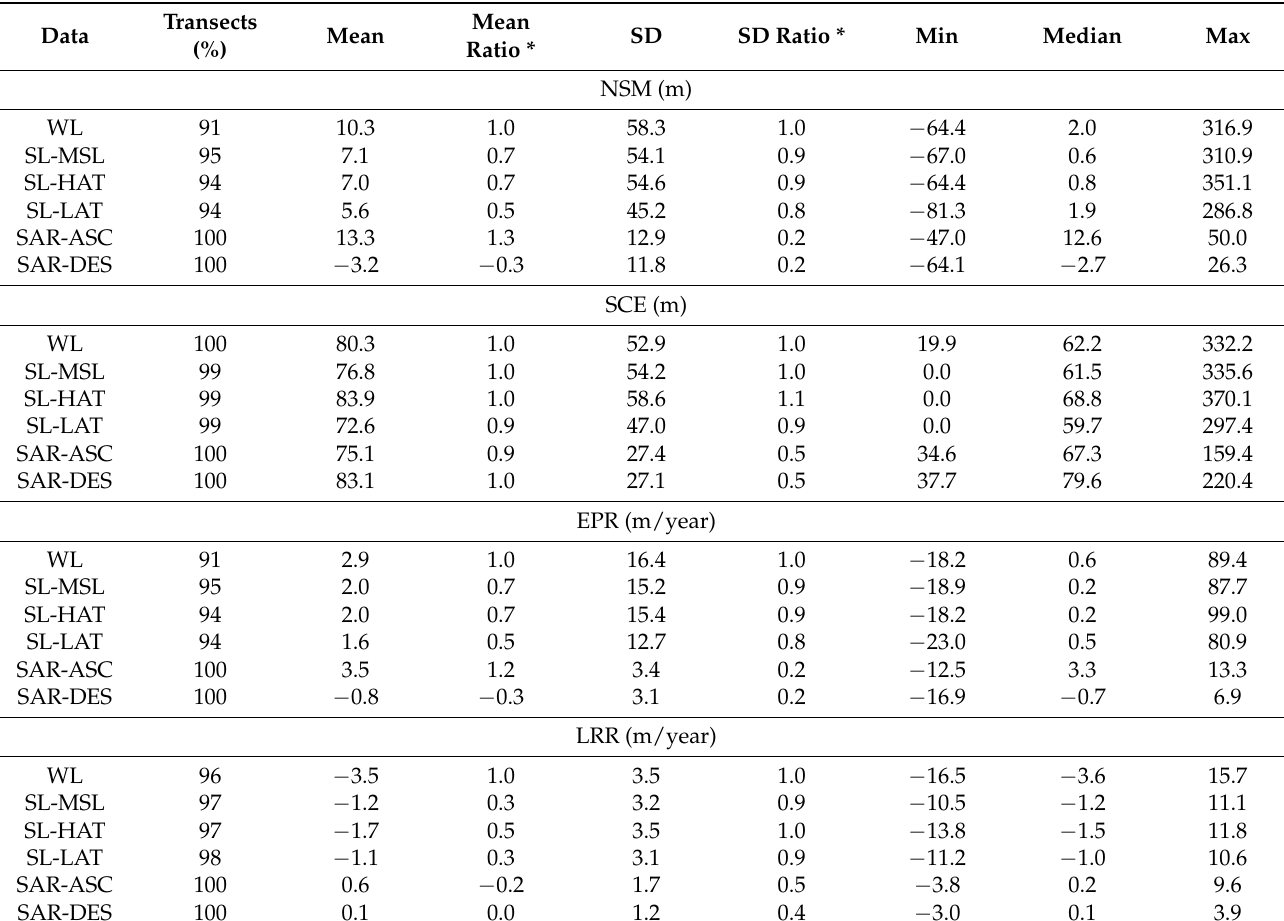
* Shown as non-dimensional Mean and Standard Deviation values obtained as the ratio of the NSM, EPR, SCE, LRR rates from different missions and line products divided by the values obtained using the MSI waterlines. Figure 14 represents EPR and LRR annual rates for each of the 1177 transects at Start Bay. The individual transect values for EPR varies from a minimum of − 23 m/year to a maximum of 99 m/year and from − 13.8 to 15.7 m/year for LRR. EPR values from datum-based MSI lines and MSL-WL are similar along the beach, with significant accretion in two sections; one at the northern end of Beesands beach and the other at the southern end of Slapton Sands, with a rocky coast separating both sections. All MSI lines show high values of erosion at the south of the study area. Values of EPR and LRR derived from SL-MSL and MSI-WL are very similar. We observed higher differences with SL-LAT, which for example is not